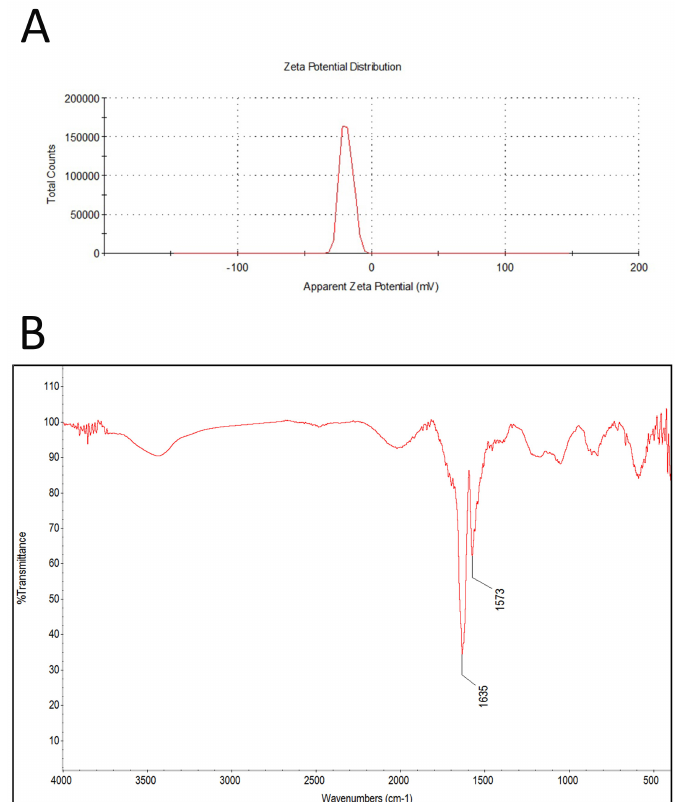
Figure 2. Test results of zeta potential ( A ), and FT-IR (ATR, attenuated total reflectance) spectrum of pristine graphene ( B ).